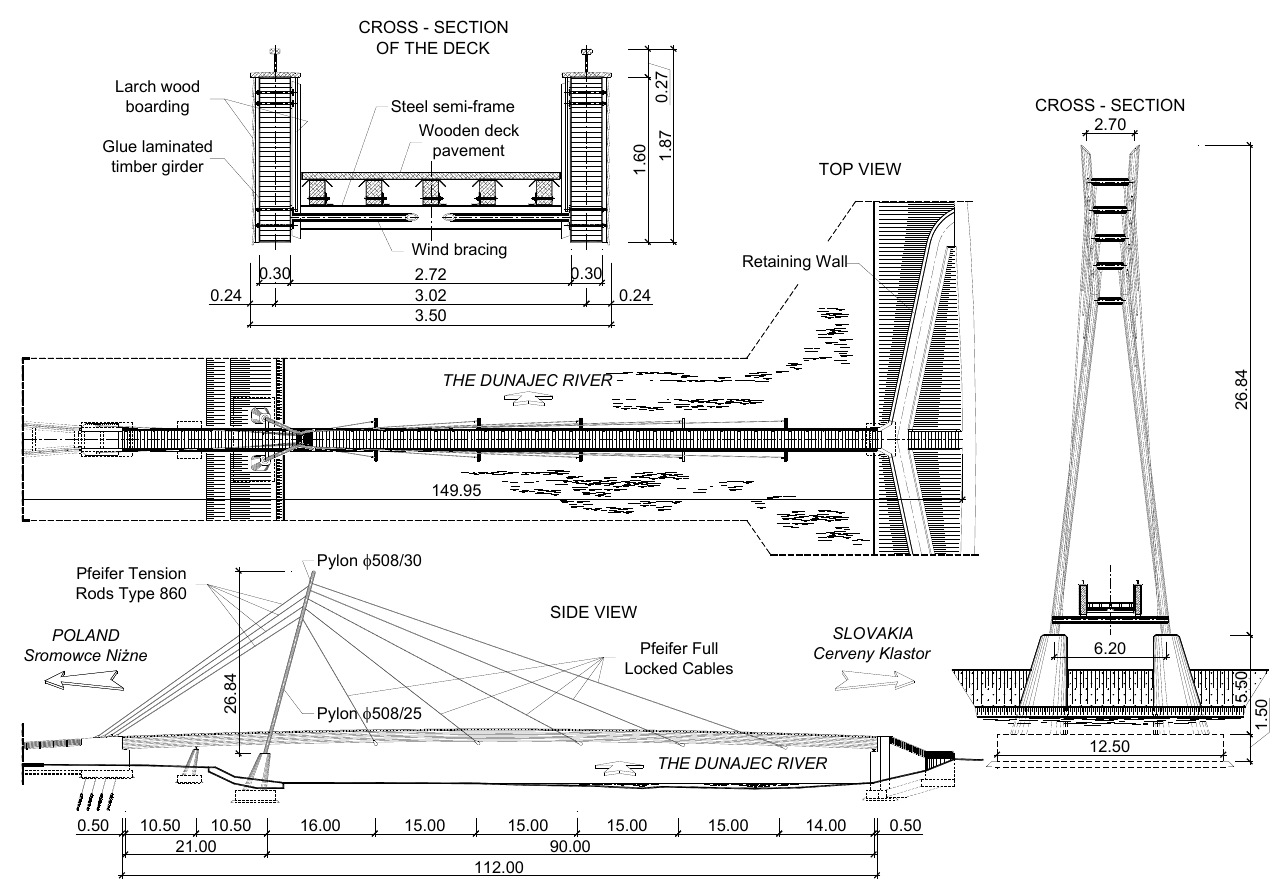
Figure 3. Structural solutions of the footbridge in the Pieniny mountains.